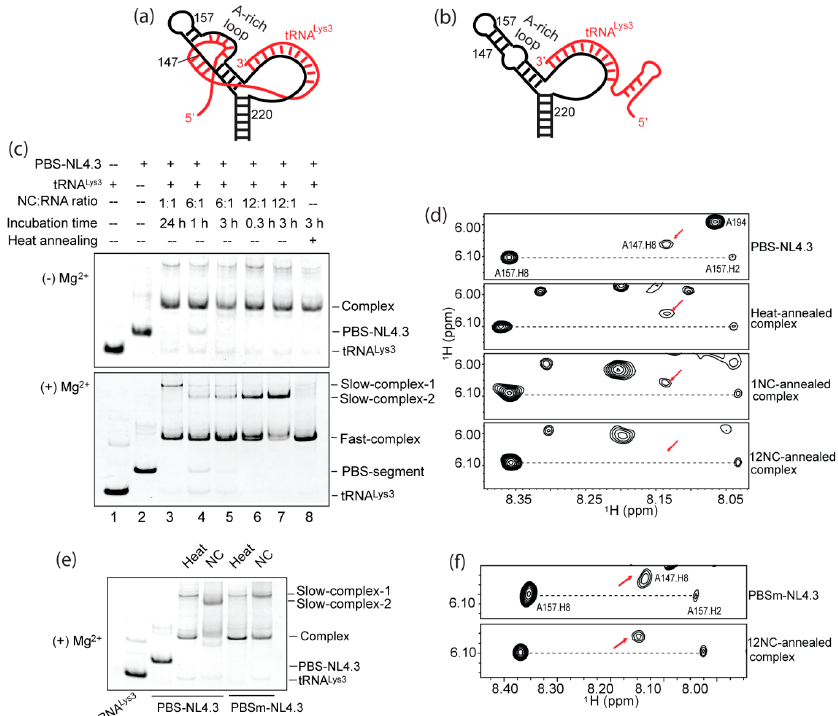
Figure 6. Native gel and NMR analysis of annealing conditions on PBS-NL4.3 and PBSm-NL4.3 show that the A-rich loop: anticodon interaction was promoted by nucleocapsid (NC) annealing but not by heat annealing. ( a ) Sketch of the A-rich loop: anticodon interaction model. PBS-NL4.3 is shown in black, and tRNA Lys3 is shown in red. ( b ) Sketch of the complex model without extended interactions. ( c ) Complexes annealed under various conditions adopt different structures. The PBS-NL4.3: tRNA Lys3 complexes were analyzed by polyacrylamide gel electrophoresis without Mg 2+ (top panel) and with Mg 2+ (bottom panel). ( d ) Portions of 2D 1 H- 1 H NMR of the PBS-NL4.3: tRNA Lys3 complexes show that only the 12:1 NC: RNA complex led to a possible A-rich loop anticodon interaction. The red arrow indicates an A147.H8 chemical shift. ( e ) Native gel analysis of the complexes of PBS-NL4.3:tRNA Lys3 and PBSm-NL4.3: tRNA Lys3 annealed by heat and by 12 NC. ( f ) Portions of 2D 1 H- 1 H NMR of PBSm-NL4.3 and the PBSm-NL4.3: tRNA Lys3 complex show that the mutation of the A-rich loop disrupted the formation of a possible A-rich loop anticodon interaction. The red arrow indicates an A147.H8 chemical shift.